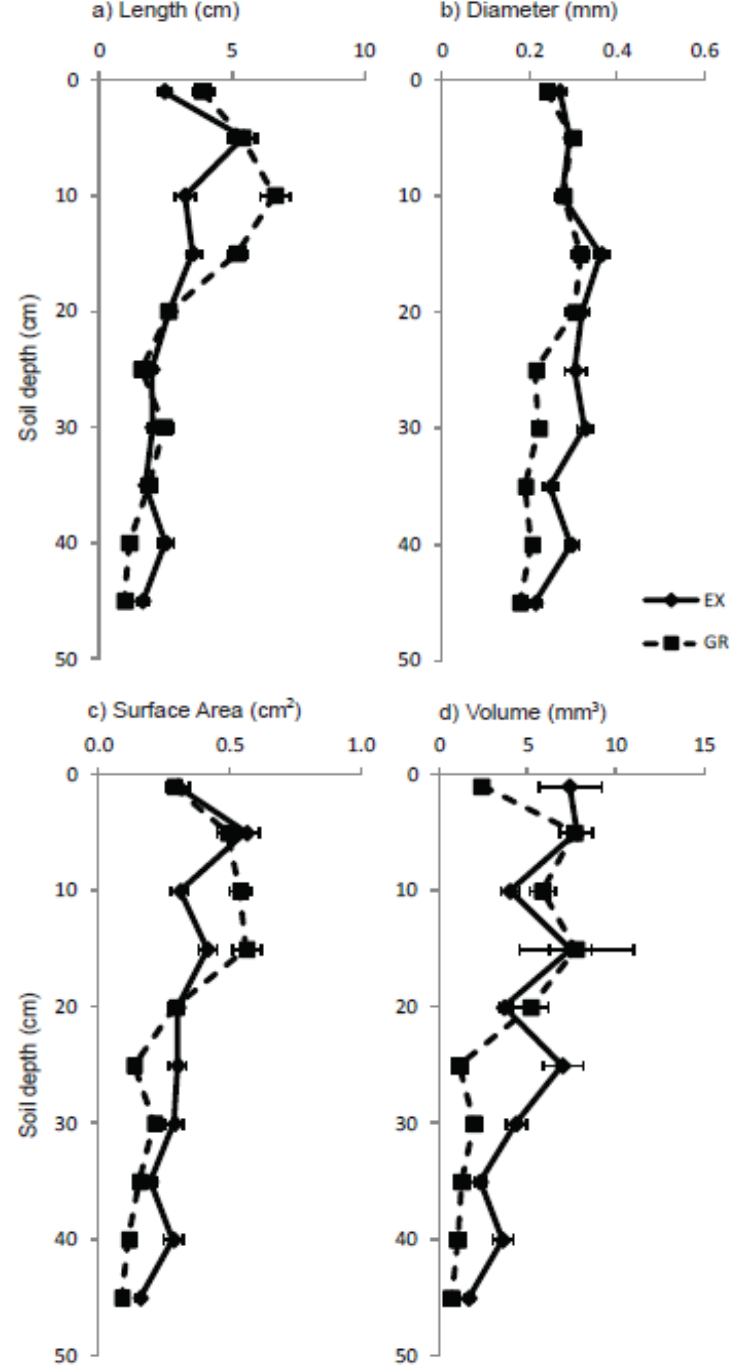
Figure 3. Thirteen-month averages by minirhizotron tube length (5 cm tube length = 3.5 cm vertical soil depth) for ( a ) total root length; ( b ) average root diameter; ( c ) total surface area; and ( d ) total root volume in soils under established native pastures managed for grazing (GR) and biomass crop exclosures